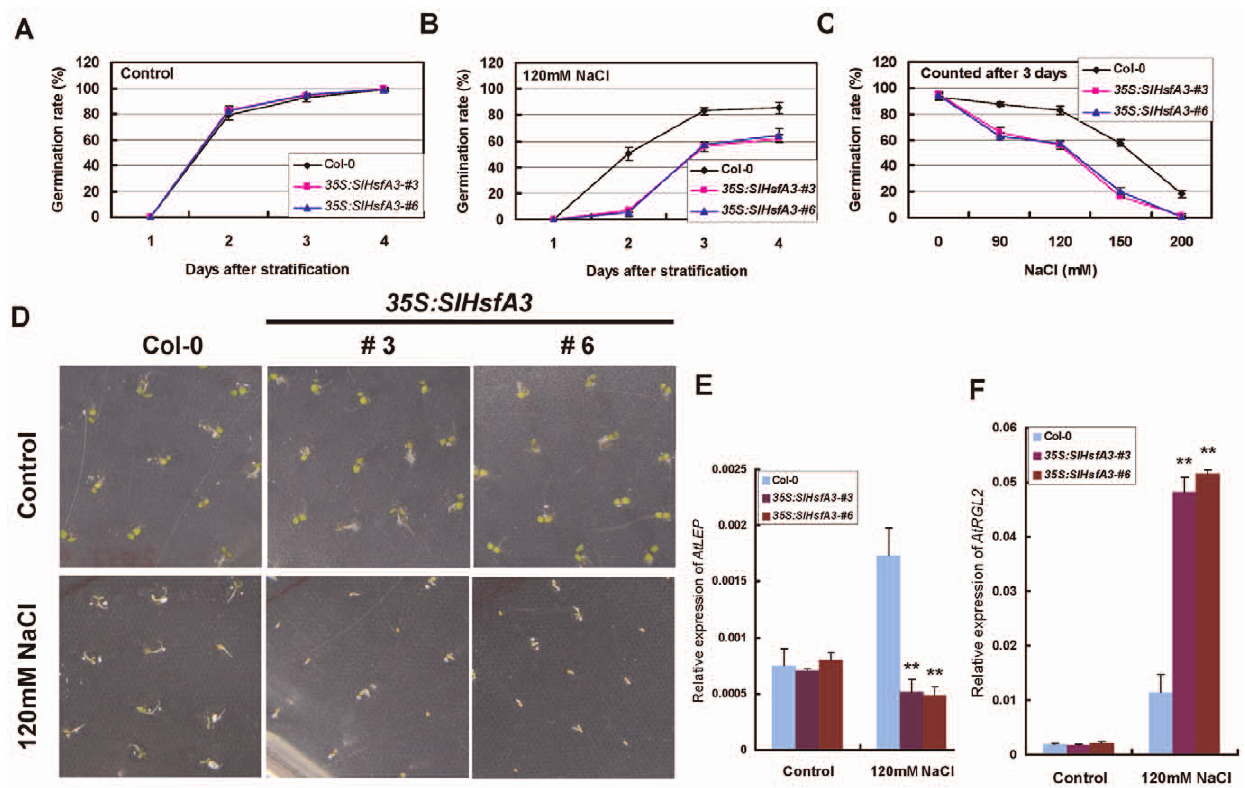
Figure 7. Germination assays of SlHsfA3 -overexpressed plants. (A–C) Seed germination ratio of Col-0 and two OE lines in the absence and presence of NaCl. Seeds from different genotypes were germinated on MS agar plates (control, A) or supplemented with 120 mM NaCl (B) or with different concentrations of NaCl (C), respectively. Germination was defined as the obvious sign of radicle tip emergence and scored daily until the indicated day after incubation at 22 u C. Data shown are average and SD of four independent experiments (each with 100 seeds for each genotype). (D) Increased germination sensitivity of SlHsfA3 transgenic lines. Pictures were taken 3 d after stratification. (E–F) Expression of AtLEP and AtRGL2 determined by qRT-PCR in germinating seeds of Col-0 and SlHsfA3 transgenic lines treated with NaCl. All seeds were harvested 16 h after stratification. Error bars denote SD from three independent biological repeats. Asterisks denote Student’s t test significance compared with Col-0 plants: **P ,